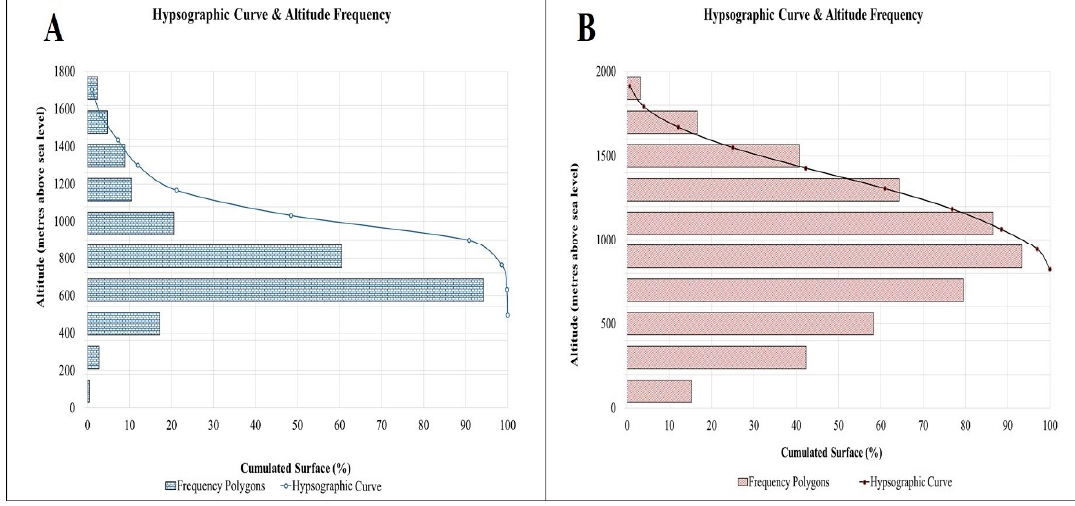
Figure 6. Hypsographic Curves of Miaogou ( A ) and Gaojiaping ( B ) Watershed.